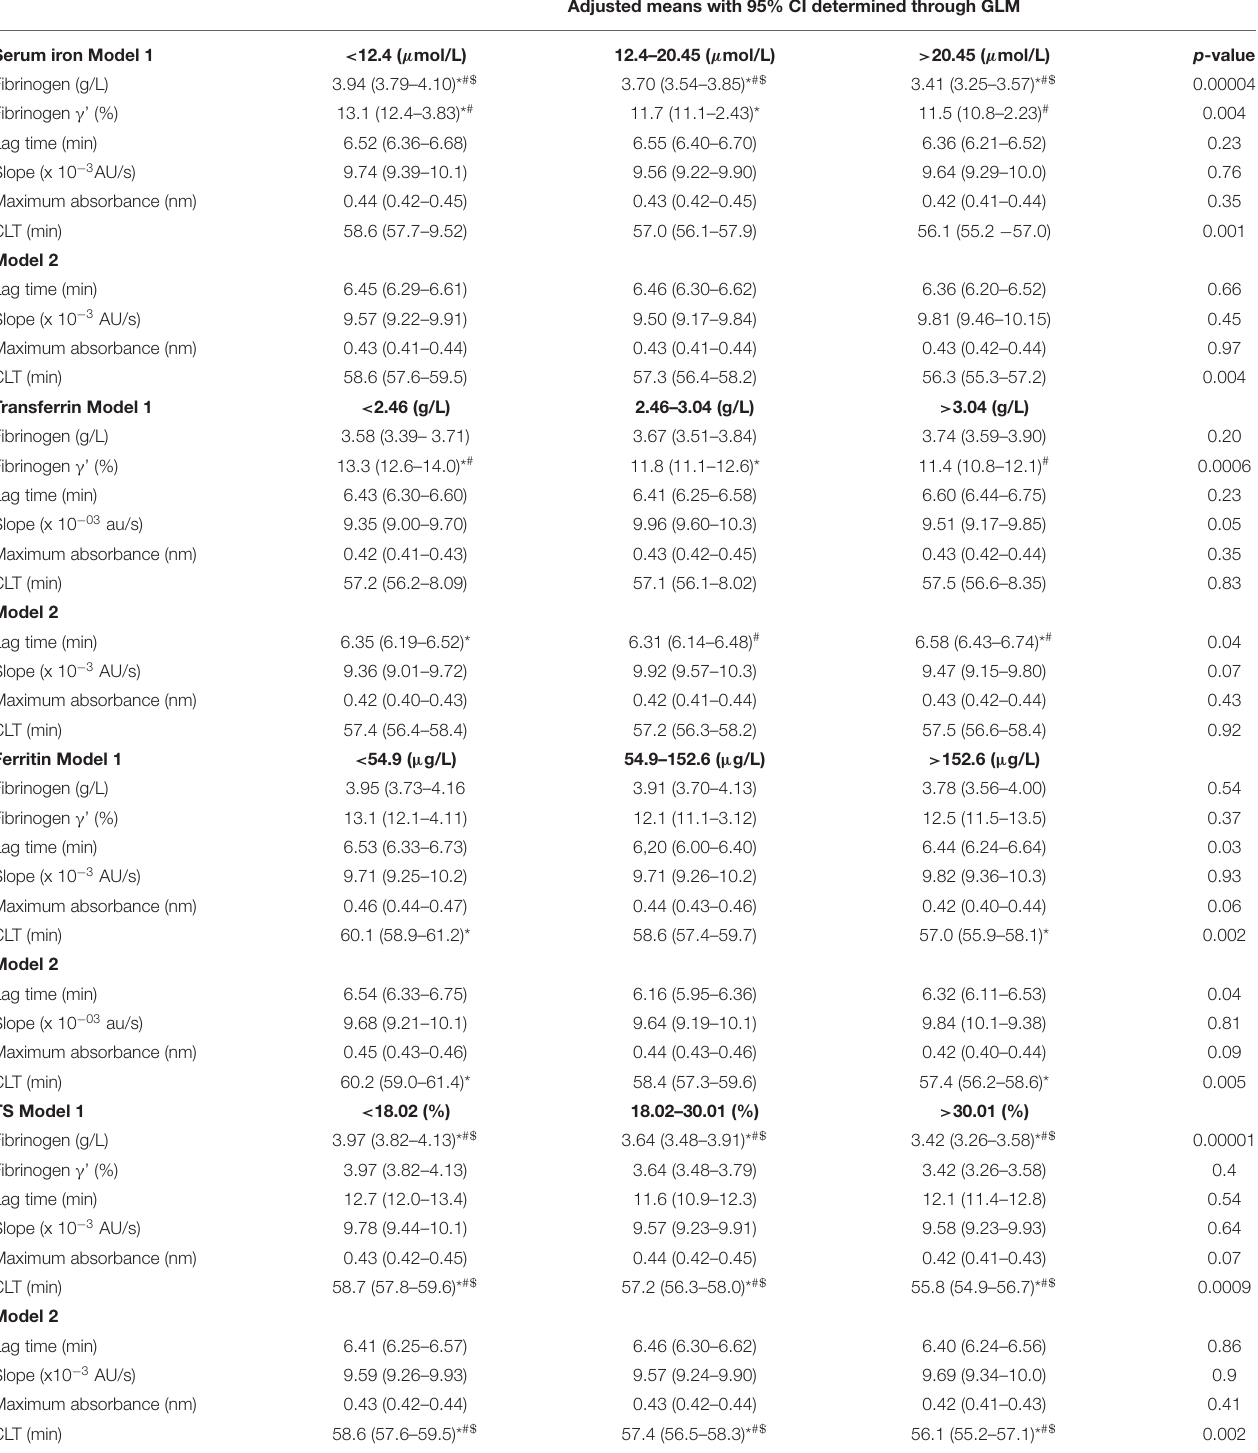
TABLE 3 | Iron biomarker tertiles in relationship to total and γ ’ fibrinogen as well as clot properties (i.e., lag time, slope, maximum absorbance, and